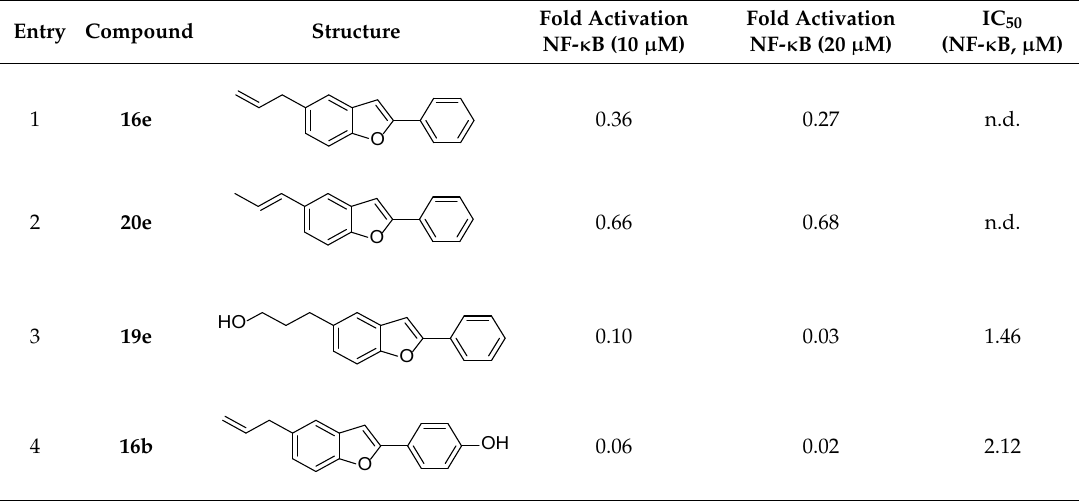
Table 3. Pharmacological data.